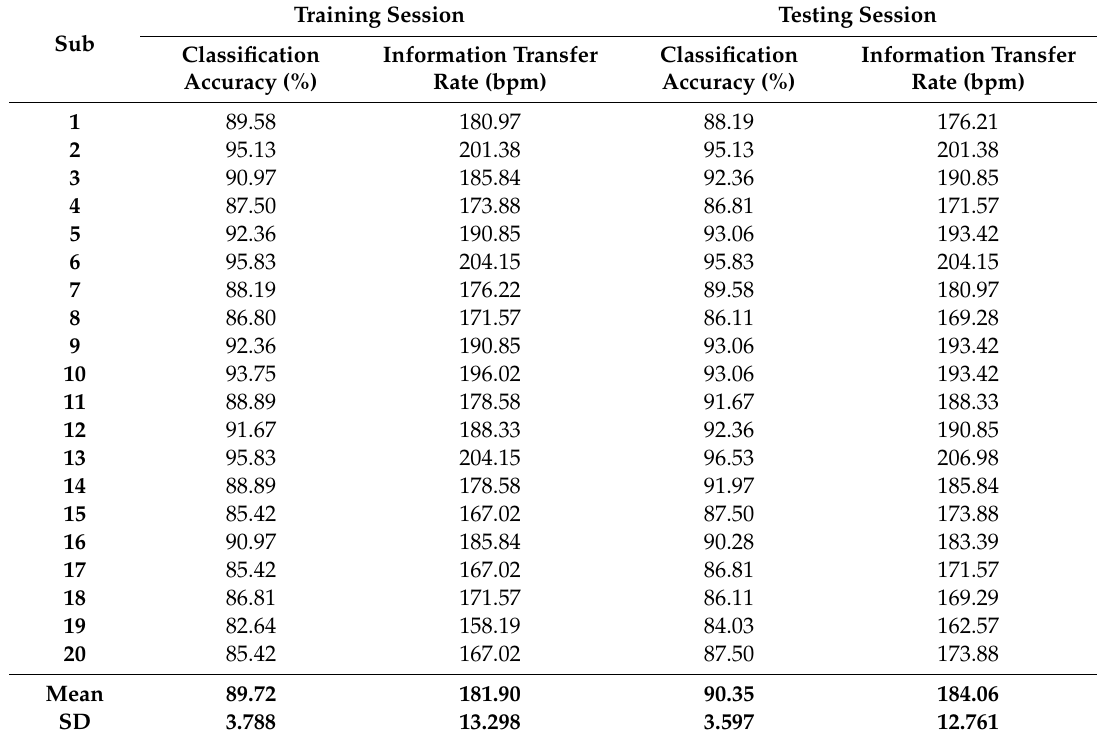
Table 3. Classification accuracy and information transfer rate for the online cued-spelling